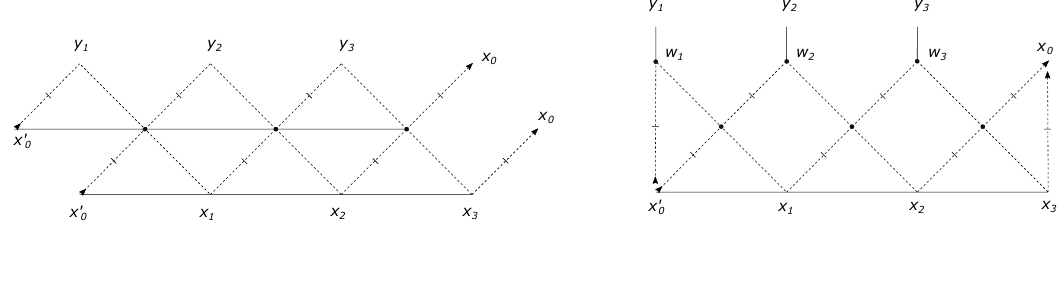
Figure 13 . Graphic representation of the integral kernel stand for scalar propagators 1 / ( z the dashed lines with a bar stand for ( ¯ σ µ ( x − y ) matrices σ , ¯ σ in the